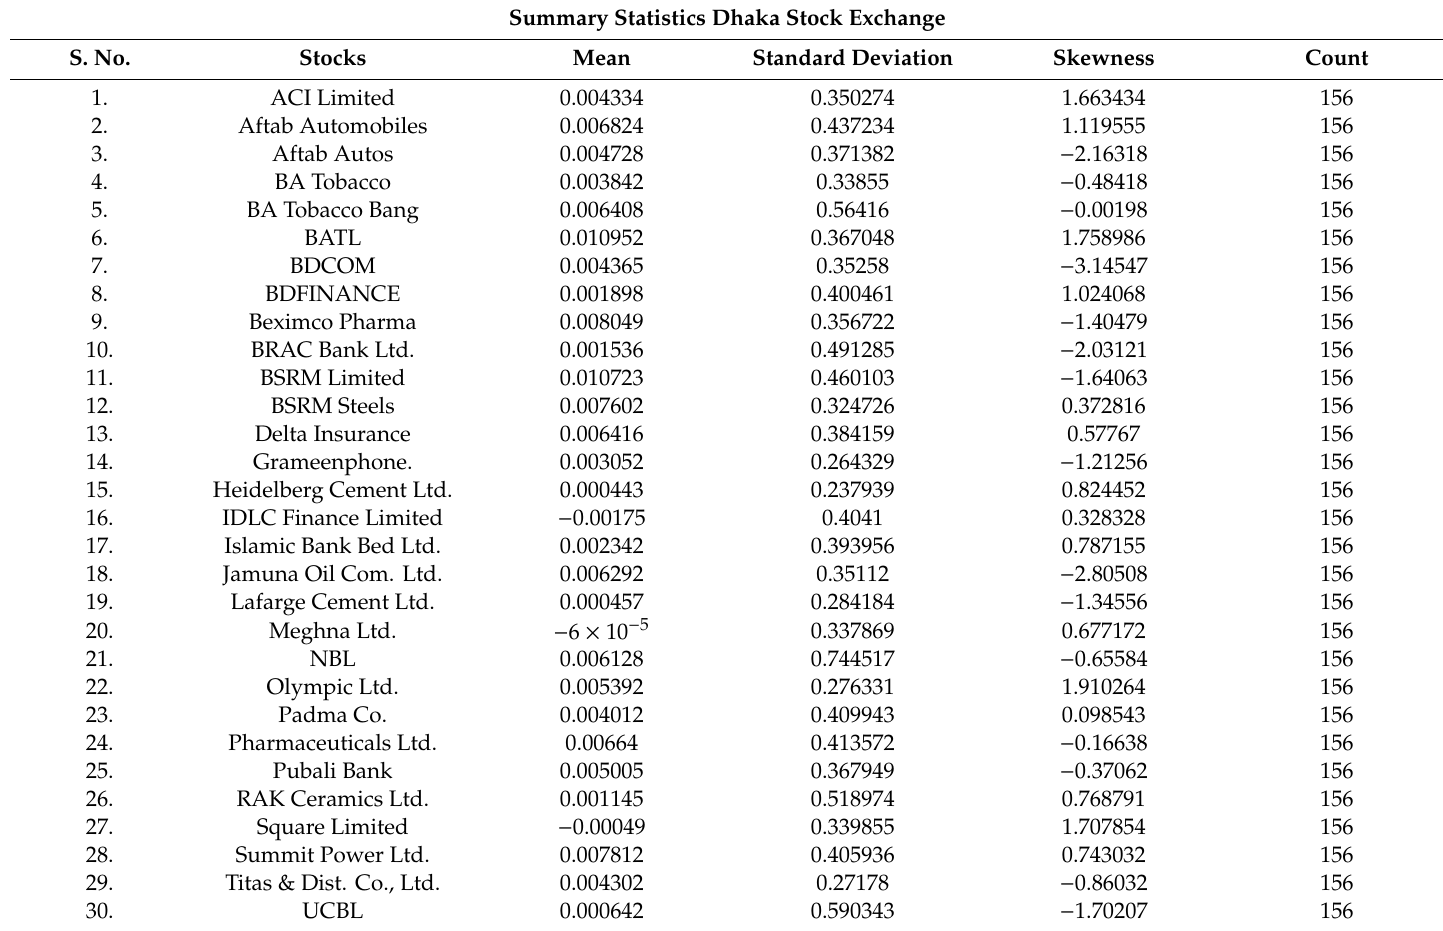
Table A4. Summary Statistics of Dhaka Stock Exchange. Summary Statistics Dhaka Stock